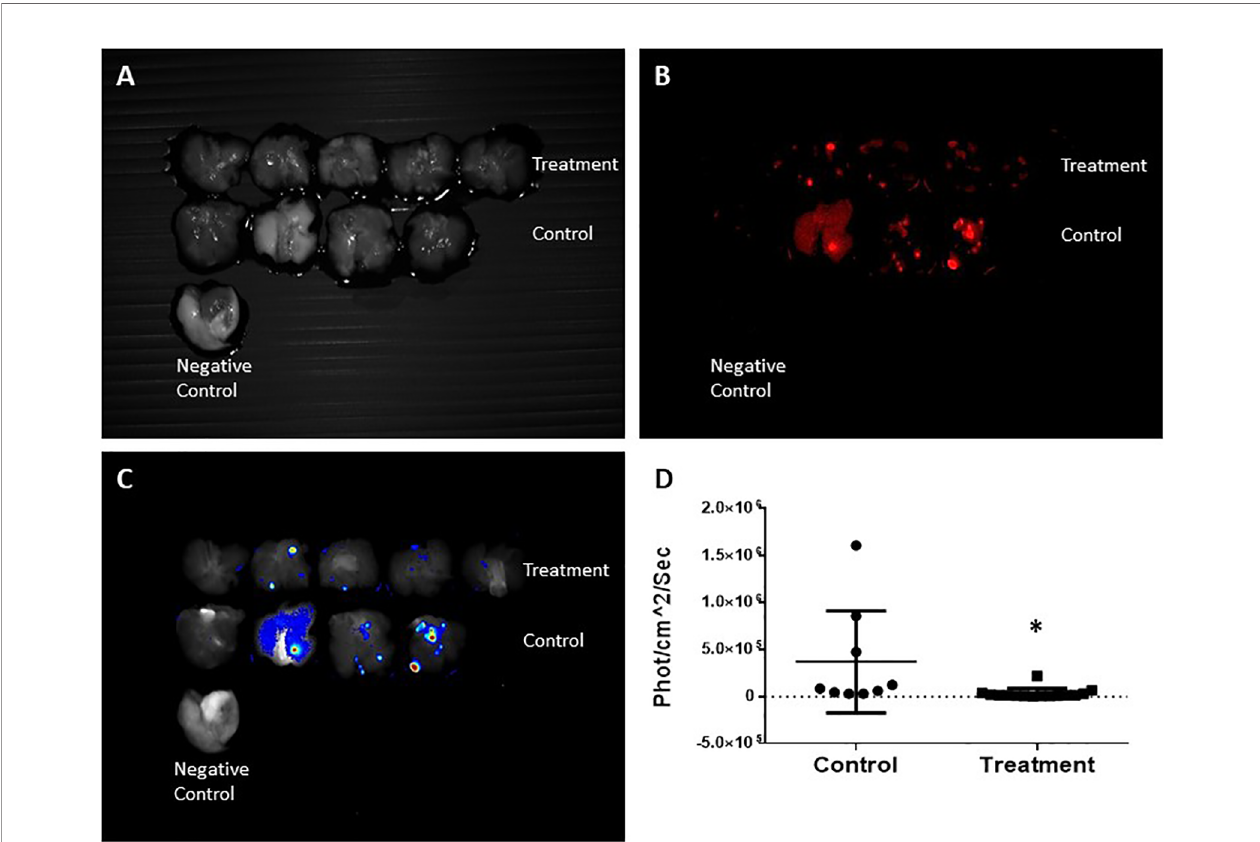
FIGURE 7 | CRi Maestro fl uorescent ex-vivo imaging of the lungs. (A) Lungs – grayscale. (B) Fluorescent imaging of mCherry metastases. (C) Heat map of viable metastases. (D) Quantitation of total fl uorescent signal in the lungs per group, expressed in x10 6 phot/cm 2 /sec. Each dot represents the fl uorescence intensity of individual metastases. Normal lungs without mCherry expression were used as a negative control. Each pair of lungs may contain several metastases that express different fl uorescence intensities. Results are representative of 3 different experiments. *Statistically signi fi cant difference.